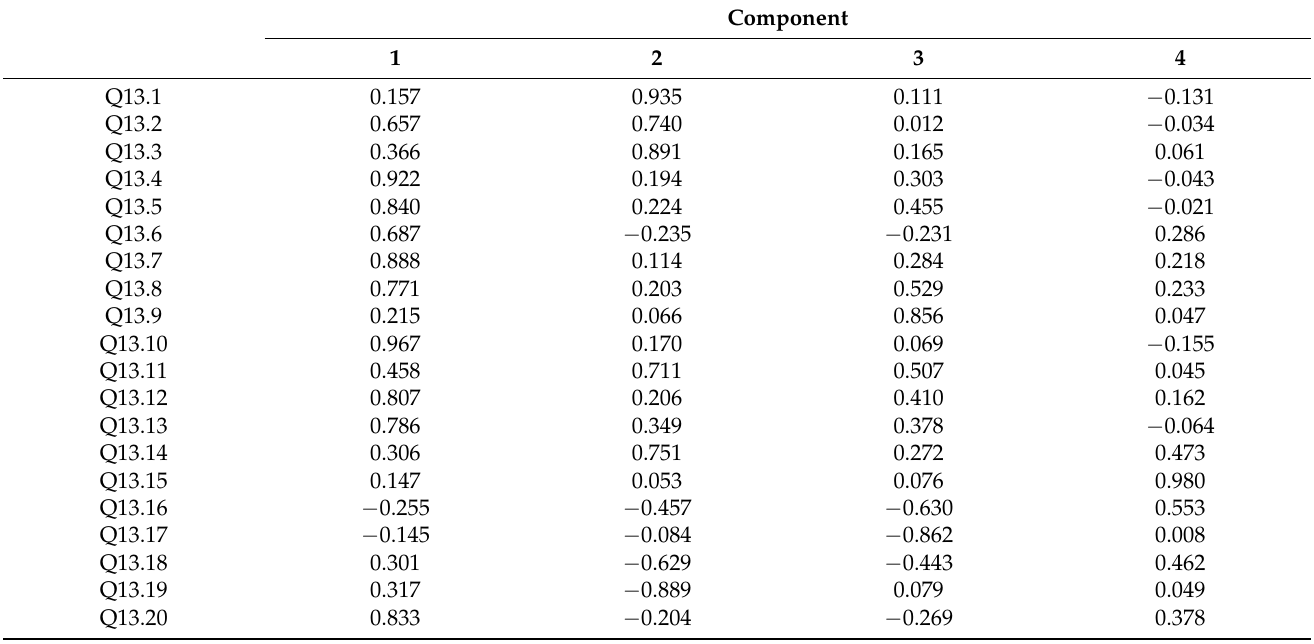
Table A6. Eigenvalues and proportion of the total variance in 9 groups of collective entrepreneurship, as explained by the first three principal components for the original 20 traits and the correlation coefficients between these traits and the first three PCs on for questions